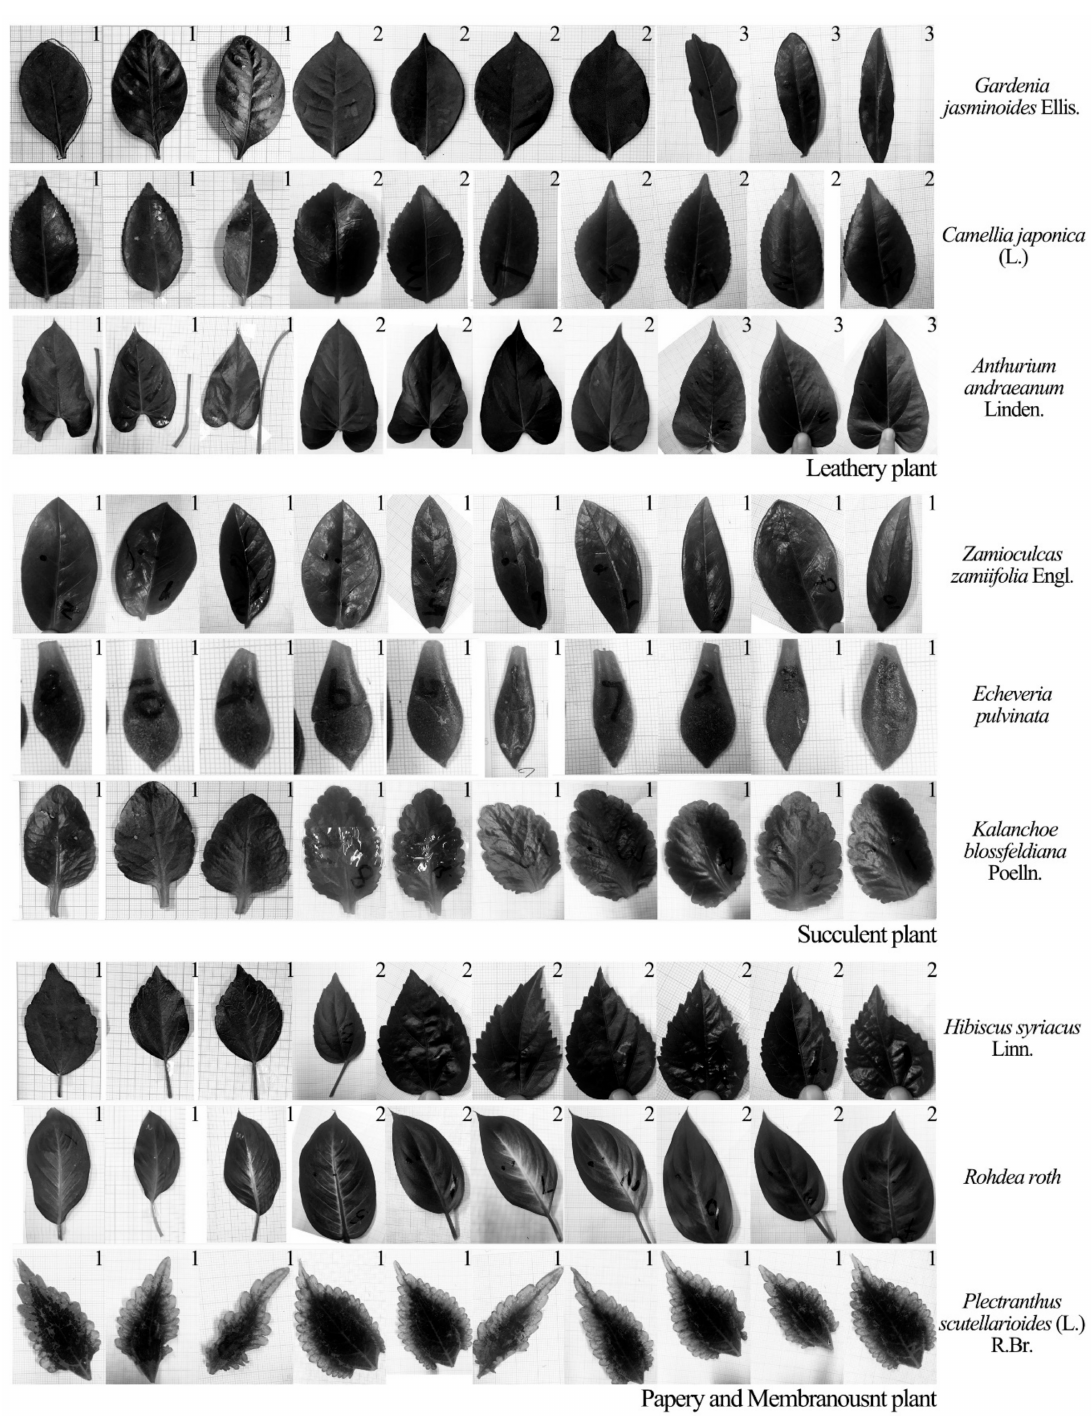
Figure 3. Plant leaves used in the